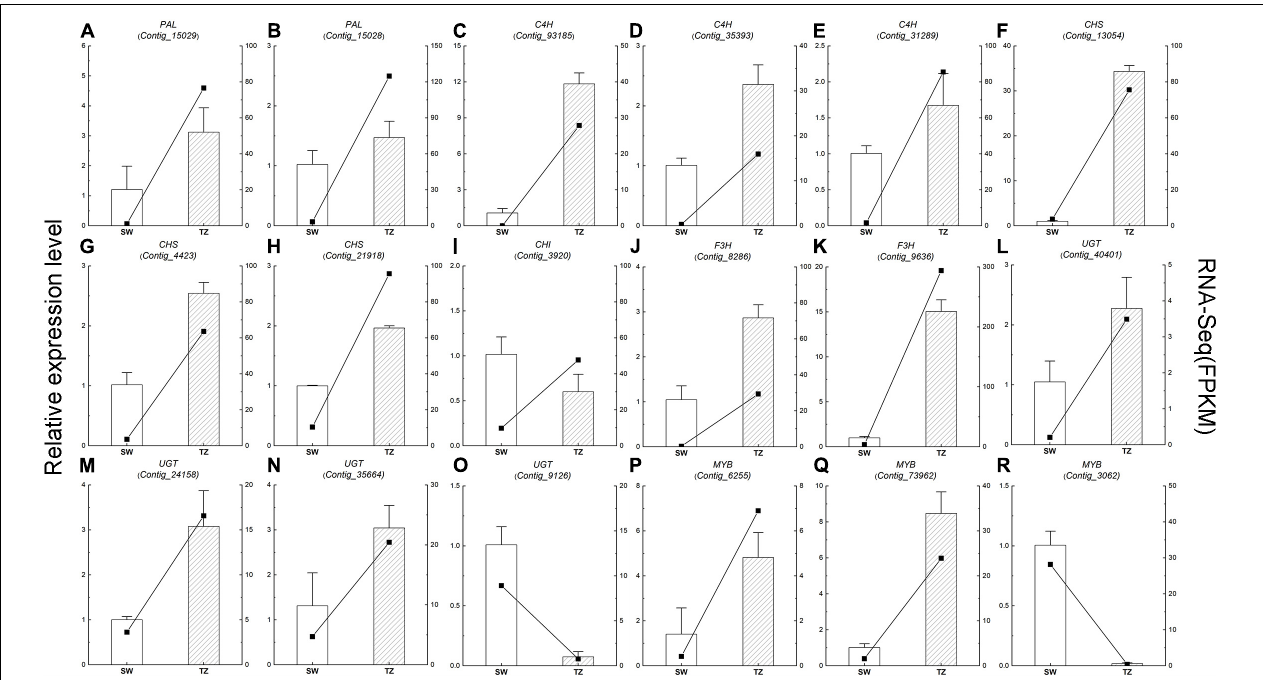
FIGURE 9 | The qRT-PCR analysis of the expression level and fragment per kilobase per million reads (FPKM) of 18 phenylpropanoid and flavonoid biosynthetic pathways candidate unigenes in RH-SW and RH-TZ. The column showed the relative expression level while the line showed the FPKM value. (A,B) Phenylalanine ammonia-lyase (PAL), (C–E) cinnamic acid 4-hydroxylase (C4H), (F–H) chalcone synthase (CHS), (I) chalcone isomerase CHI, (J,K) flavanone 3-hydroxylase (F3H), (L–O) UDP-glycosyltransferase (UGT), and (P–R)